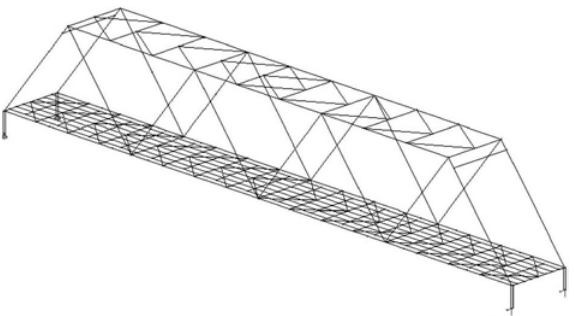
Fig. 10. Beam-and-shell element computational model